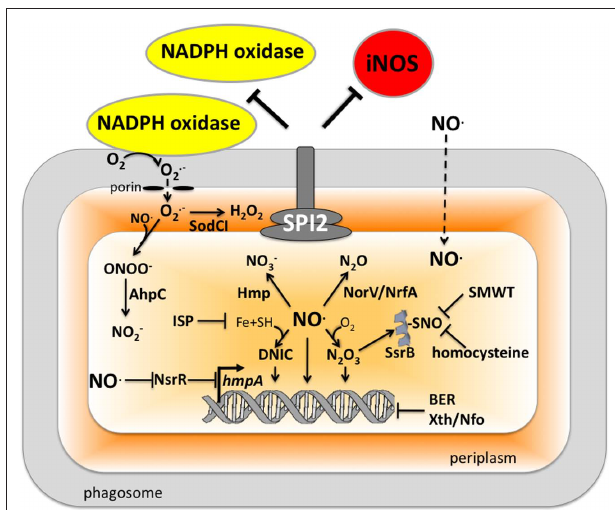
Figure 2 | Antinitrosative defenses of Salmonella . Effectors secreted by the type III secretion system encoded within SPI2 actively avoid NADPH oxidase- and iNOS-containing vesicles. Superoxide (O 2 − ) produced by the enzymatic activity of NADPH oxidase enters the periplasmic space of Salmonella through porins, while NO can freely diffuse across membranes. Overlapping NADPH phagocyte oxidase and iNOS activities can generate the potent oxidant peroxynitrite (ONOO − ) through the reaction of NO with O 2 − . The negative effects of ONOO − are alleviated directly by the enzymatic activity of alkyl hydroperoxidase (AhpC) or indirectly by periplasmic SodCI, which − and thereby limits ONOO − formation. NO can be directly detoxifies O 2 reduced by the denitrosylase activity of the flavohemoprotein Hmp. Transcription of hmpA is de-repressed by the inactivation of the [2Fe–2S] redox active prosthetic group of the NsrR transcriptional repressor by NO. In hypoxic or anaerobic conditions, both the flavorubredoxin (NorV) and the cytochrome c nitrite reductase (NrfA) can reduce NO to nitrous oxide (N O). 2 NO interacts with iron (Fe) and small-molecular weight thiols (SMWT) to generate dinitrosyl–iron complexes (DNICs), while its reaction with O gives 2 rise to dinitrogen trioxide (N O ). Iron storage proteins (ISP) such as ferritins 2 3 can limit the generation of DNICs by restricting available Fe. Homocysteine or SMWT antagonize the S-nitrosylation associated with N O or DNIC. The SPI2 2 3 regulator SsrB is an example of a Salmonella protein that gets S-nitrosylated. A variety of RNS can oxidize purines and pyrimidines in the chromosome of Salmonella . The combined action of base excision repair (BER) glycosylases and Xth/Nfo endonucleases can repair